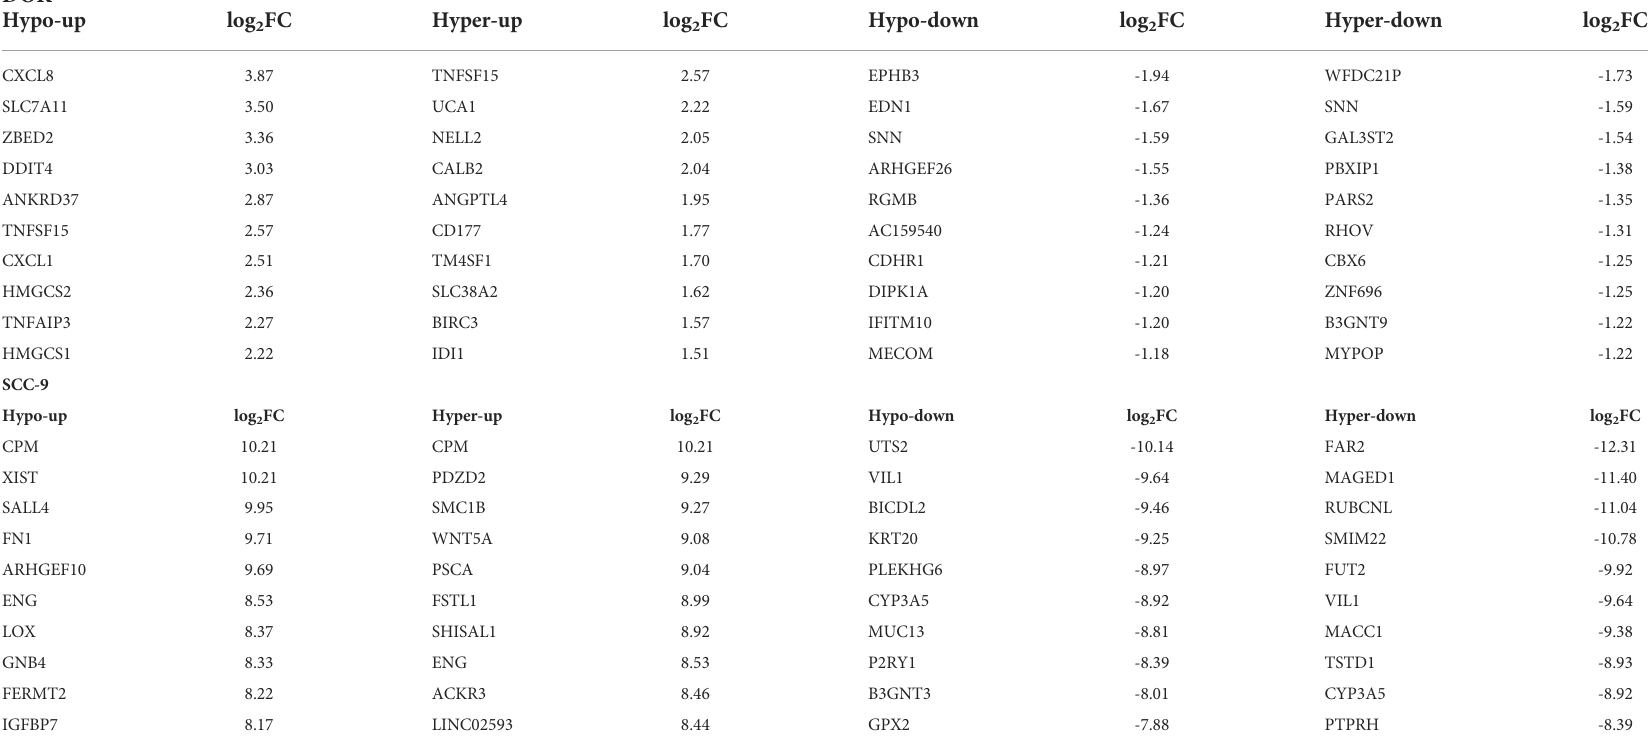
TABLE 3 The fi rst 10 differentially expressed genes with differential m 6 A peaks in DOK cells or SCC-9 cells compared with HOEC cells. DOK